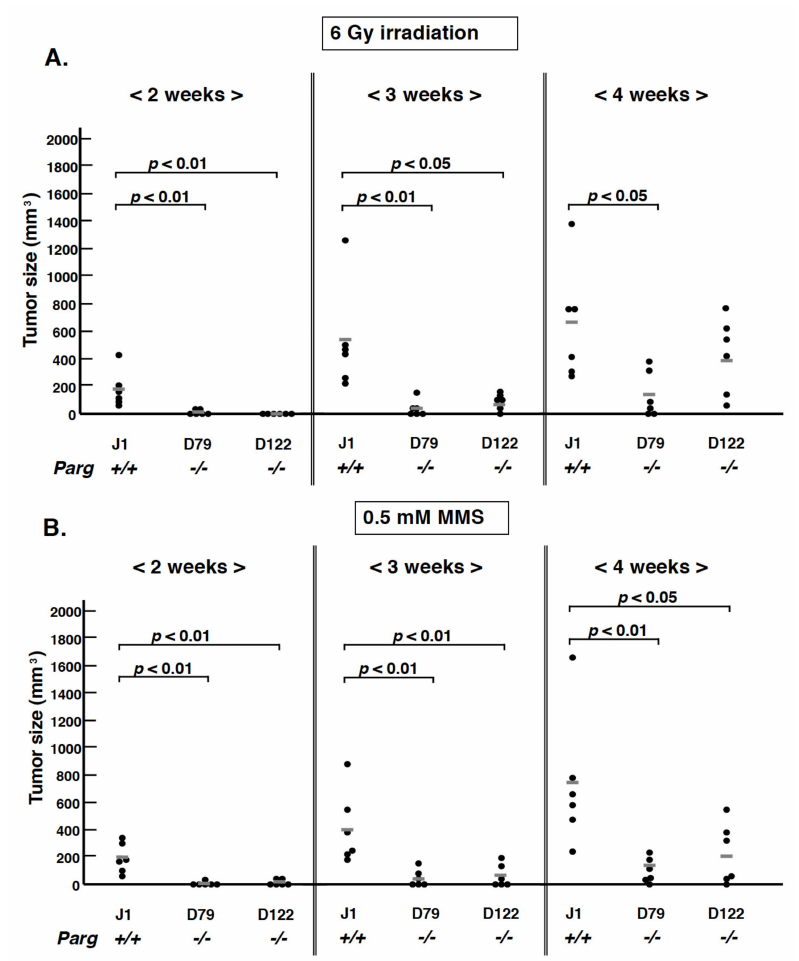
Figure 3. E ff ect of Parg deficiency on tumorigenesis from ES cells pretreated with MMS or γ –irradiation before injection into nude mice. ES cells treated with γ –irradiation at 6 Gy ( A ) or 0.5 mM MMS ( B ) and cultured for 3 h, respectively, were inoculated s.c. into nude mice. Tumor growth was observed for four weeks. The bars show the mean